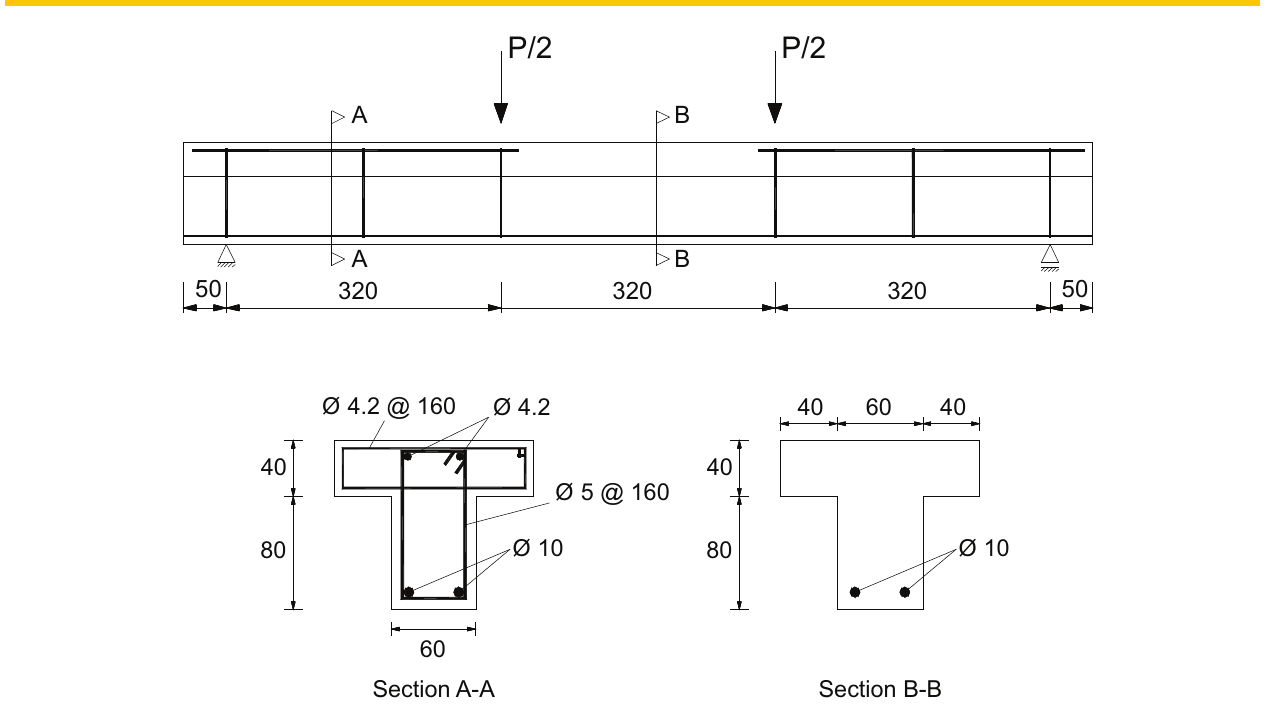
Figure 2 – Geometry and reinforcement layout of tested beam VT-NA-SE-02 (dimensions in mm)